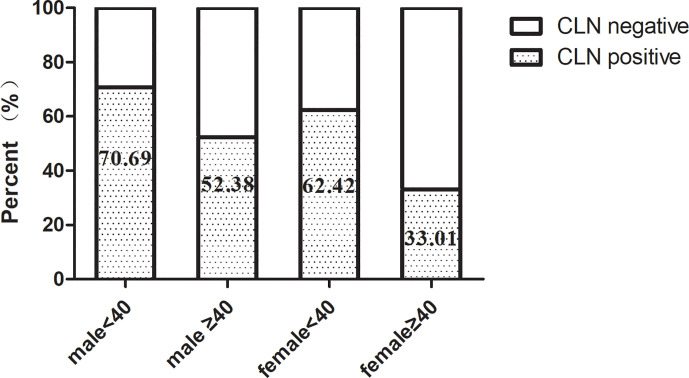
Central lymph node metastasis rate according to sex and age.